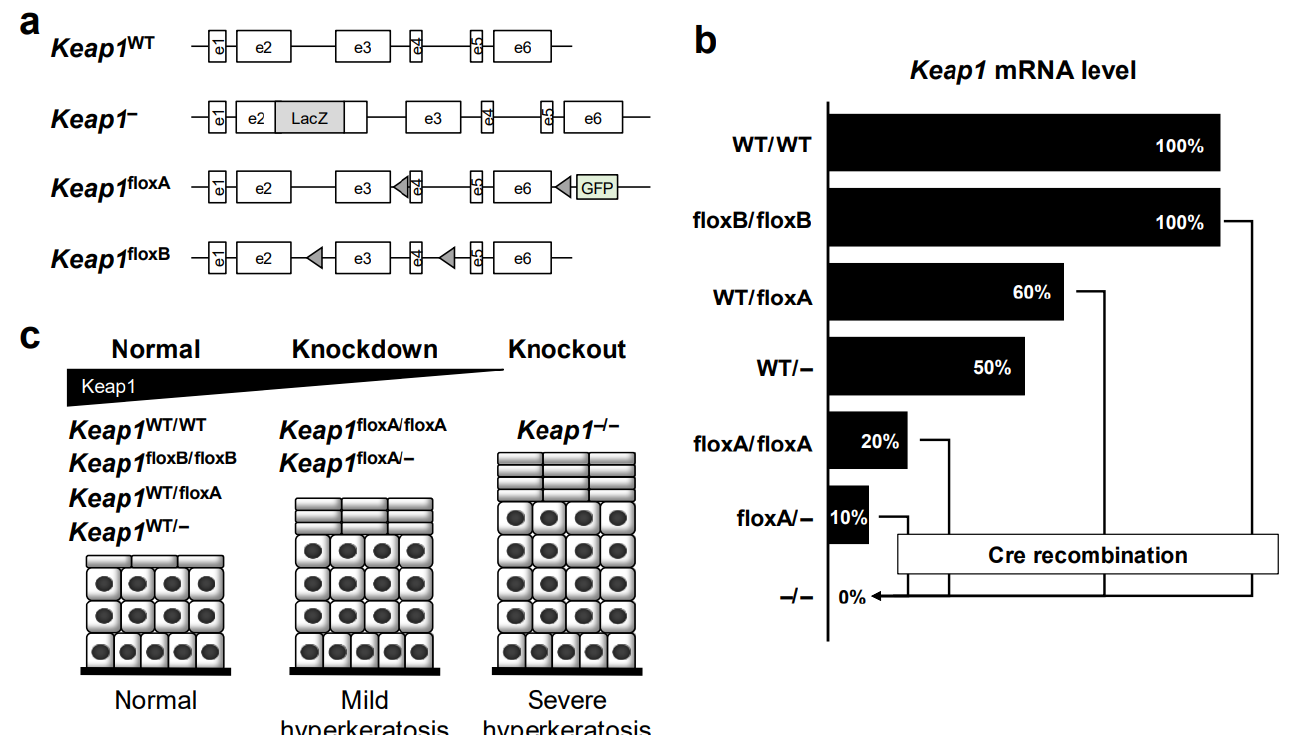
Figure 5. Genetically modified Keap1 and esophageal phenotypes in mice. ( a ) Construction of Keap1 - modified genes in mice. Diagrams of wild-type (WT), systemic knockout (–/–), and Keap1 flox mice (two lines) are shown. ( b ) The expression level of Keap1 mRNAs in Keap1 genetically modified mice. The Keap1 mRNA expression from the Keap1 floxB allele is comparable with that of the WT allele in the absence of Cre recombination. The expression in the homozygous Keap1 floxA allele is decreased to 20% of that of the WT allele, even in the absence of Cre recombination. Keap1 in floxA/floxA, floxB/floxB or floxA/– appears to be substantially deleted in the presence of Cre recombination. ( c ) Keap1-dependent hyperkeratosis in the esophageal epithelium of Keap1 genetically modified